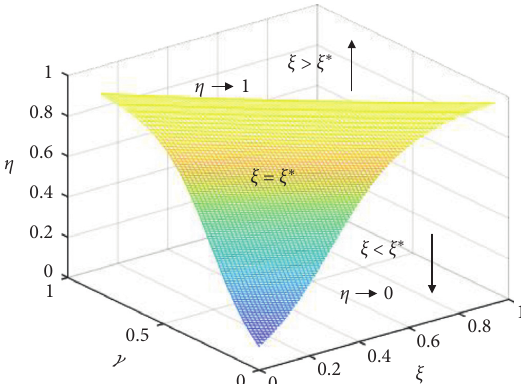
Figure 5: Evolutionary phase diagram of central government’s strategy